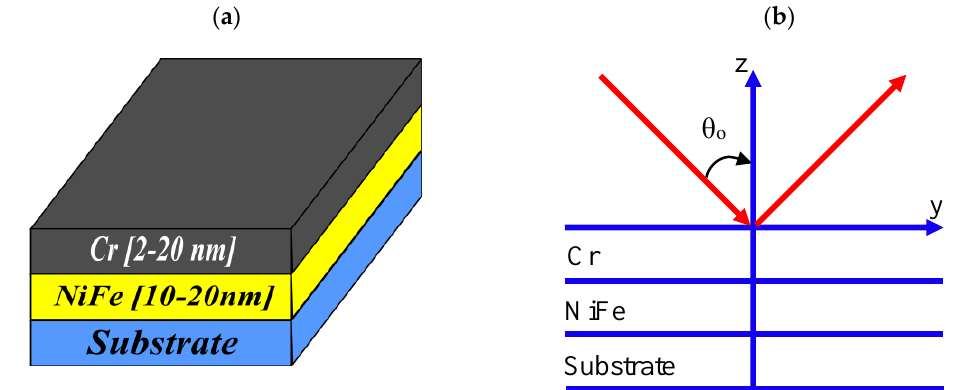
Figure 1. ( a ) Structure of the fabricated samples and ( b ) the optical scheme.